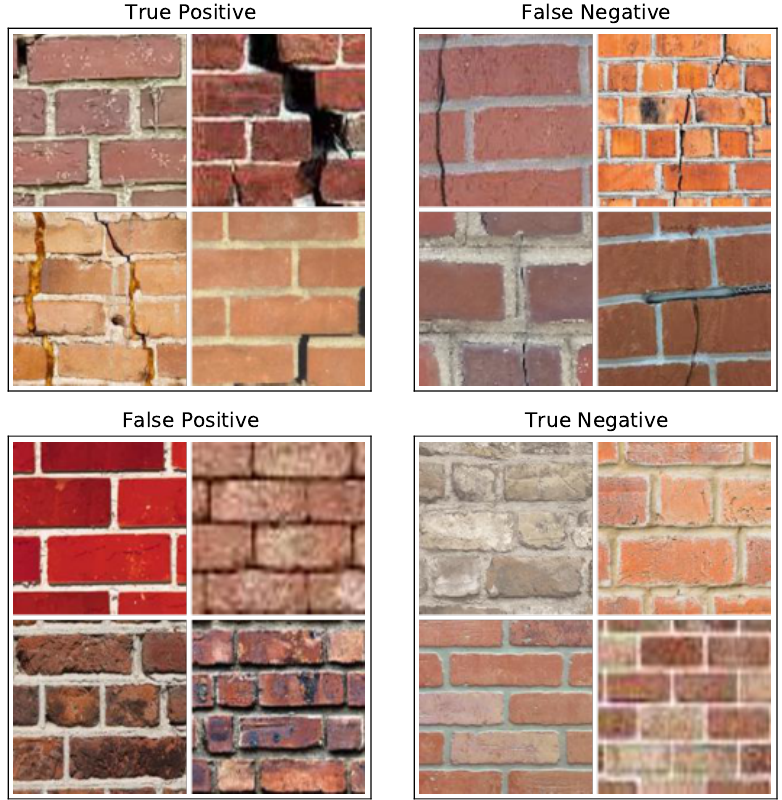
Figure 9. A random sample of four real-world images from each case in the confusion matrix, as determined by Model C.